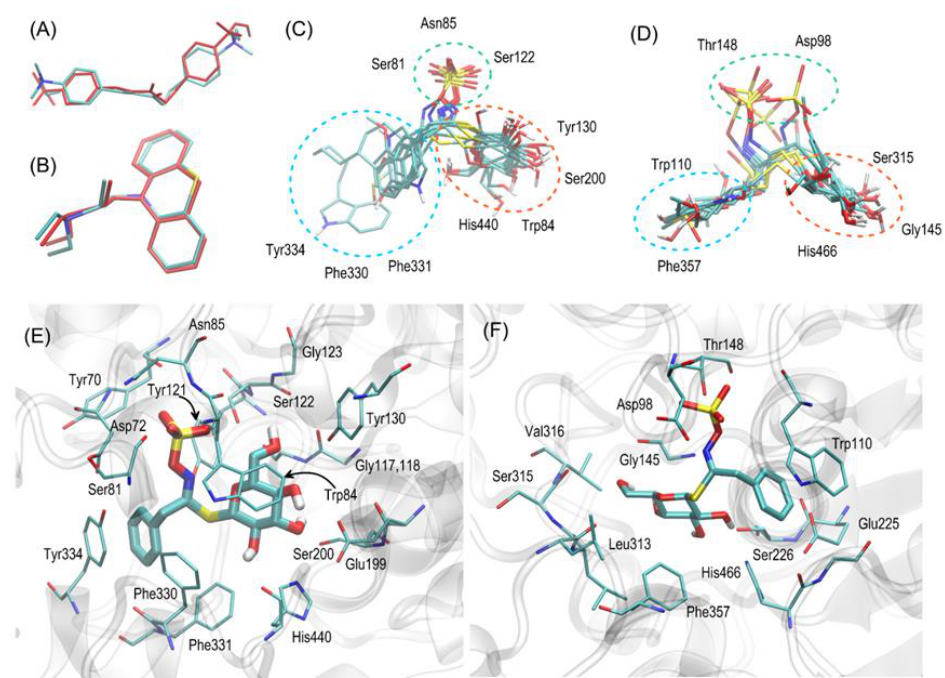
Figure 7. ( A , B ) The graphical illustration of the validation results, i.e., the superposition of the most favorable ligand poses found during docking (colored in red) with the position of the co-crystalized ligand, present in the binding cavity of AChE ( A ) or BuChE ( B ) (colored by atom type). ( C , D ) The superposition of the most favorable poses of all ligands interacting with either AChE ( C ) or BuChE ( D ). The selected amino acids creating the most essential ligand – protein contacts are given sepa- rately for each of ligand moieties. ( E , F ) The most favorable location of compound glucotropaeolin molecule bound to either the AChE ( E ) or BuChE ( F ) structure. The ligand molecule is shown as thick sticks, whereas all the closest amino acid residues (of distances no larger than 0.4 nm) are represented by thin sticks. The description of the interaction types is given in the text. All ligands prefer roughly the same binding position in the enzyme cavity, which enables them to block catalytic sites (proximity to the tryptophan and histidine residues). The relative molecular orientation is (in majority of the cases) the same among compounds interacting with the same protein. In the case of AChE, the – R substituent (usually of either aromatic or aliphatic char- acter) interacts with the cluster of aromatic amino acid sidechains (Phe330, Phe331, and Tyr334). The corresponding interactions are of either p-p, CH-p stacking or simply hydro- phobic nature. The opposite site of the ligand molecule (glucopyranose moiety) interacts with hydrogen-bonding-acceptor-containing amino acid residues (Glu199, Ser200, Tyr130, and His440) mainly by hydrogen bonding. Additionally, the CH-p stacking in- volving Trp84 and hydrophobic patch in the glucose ring is observed (This type of inter- action is characteristic of non-charged carbohydrate – protein binding [49]. As indicated by the dispersion of the poses (including secondary and tertiary ones), the glucopyranosidic moiety is much more conformationally flexible in comparison to the – R substituent. Fi- nally, the charged sulfate group, located in the central part of the ligand molecule, creates some attractive, hydrogen-bonding-mediated interactions with Ser122 and Asn85 (back- bone fragment). As the sulfate moiety is located close to the entrance to the binding cavity, it is also possible that multiple interactions with polar water molecules are possible (as no explicit solvent was considered during the docking procedure, this has not been defini- tively confirmed).